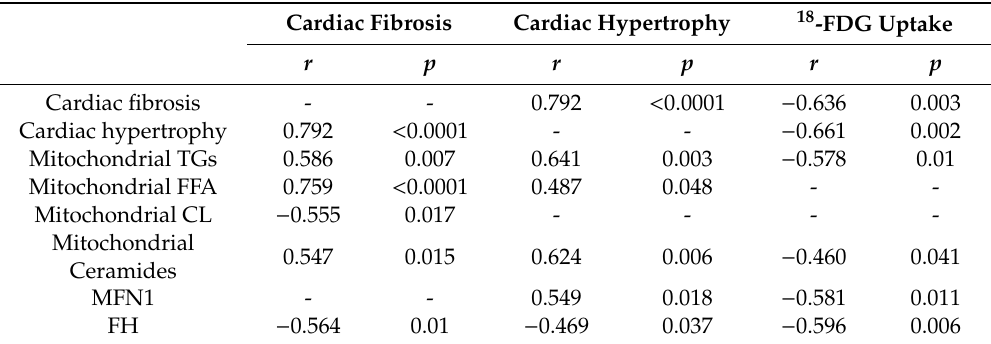
Table 2. Association between cardiac fibrosis, hypertrophy, and 18 -FDG uptake, and those of mitochondrial lipid composition and proteins in the hearts of rats fed either a normal chow (CT) or a high fat diet (HFD) treated with vehicle or MitoQ (200 µ